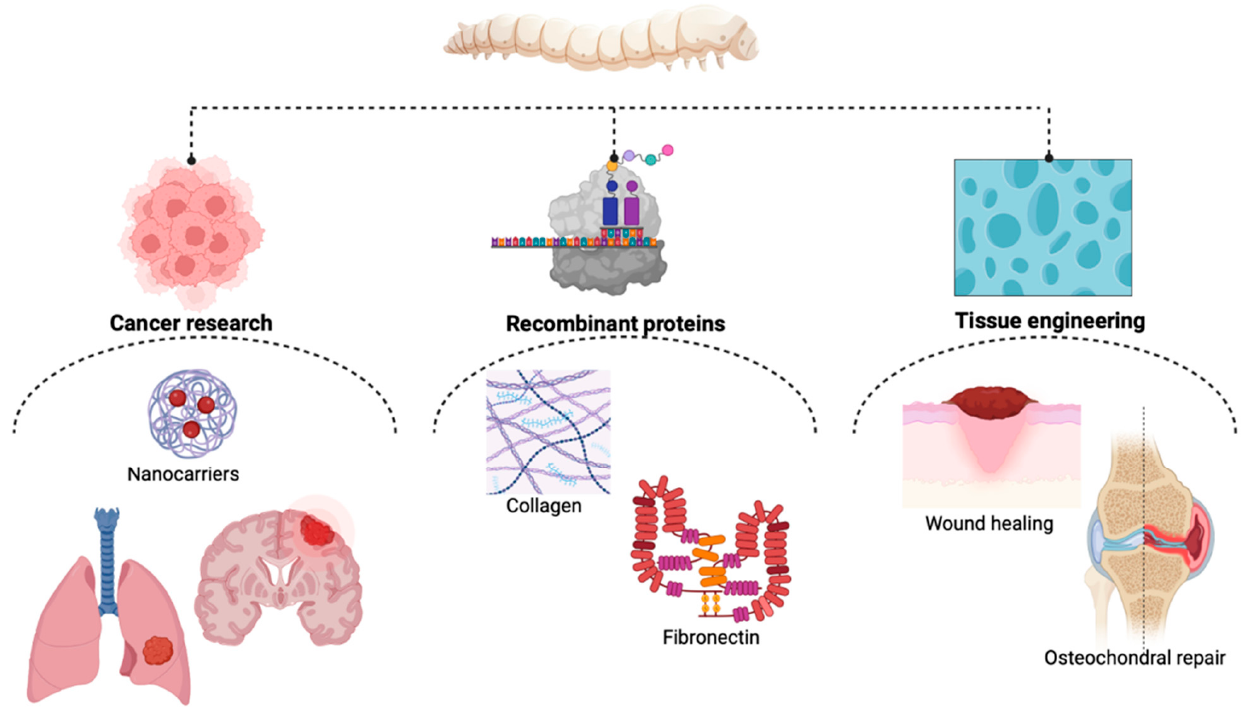
Figure 1. B. mori ’s applicability in biomedicine (Created with BioRender.com, accessed on 23 November 2022).